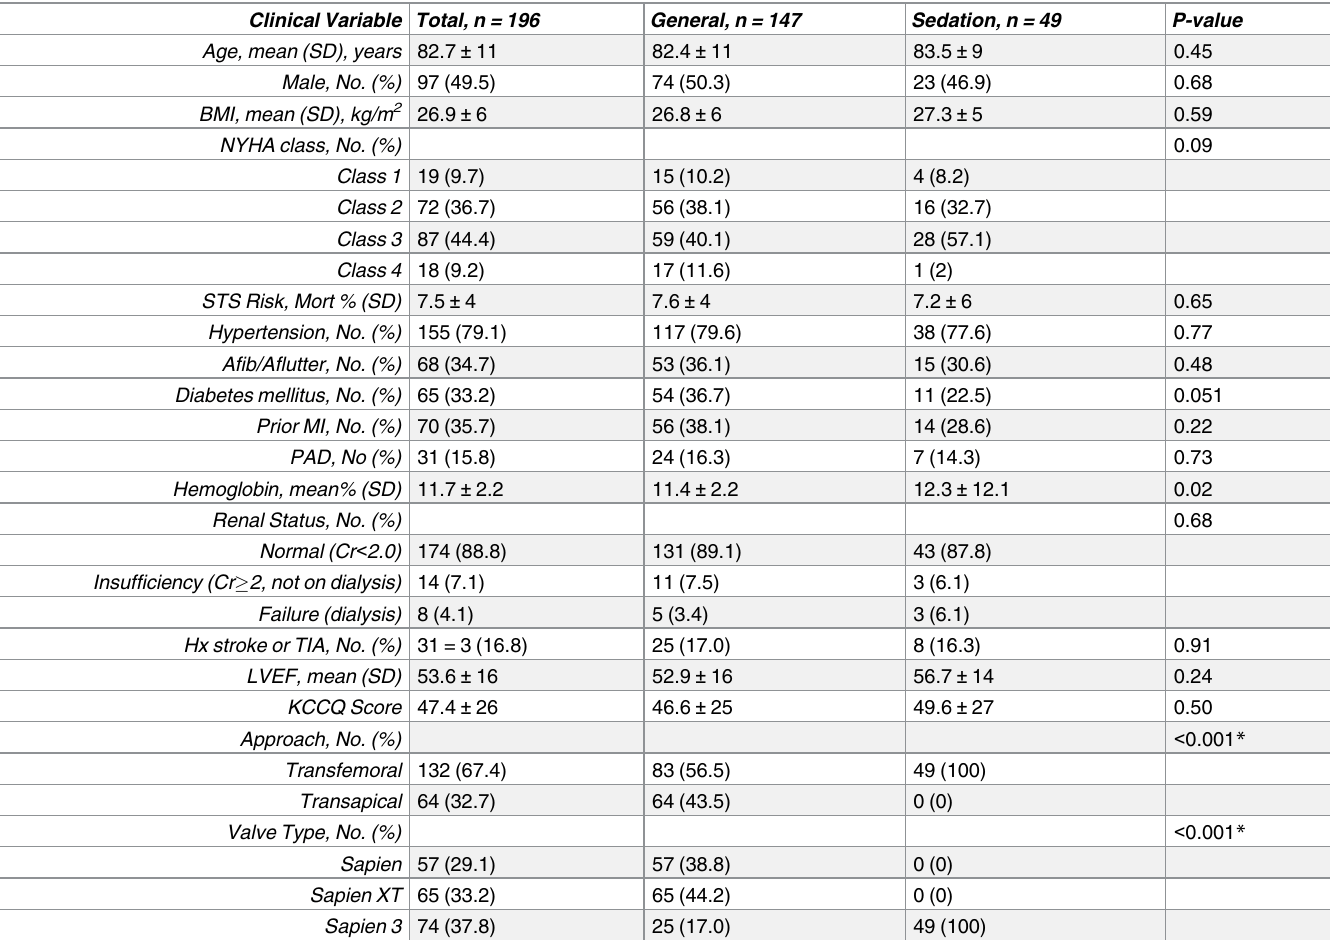
Table 1. Patient Characteristics, all matched